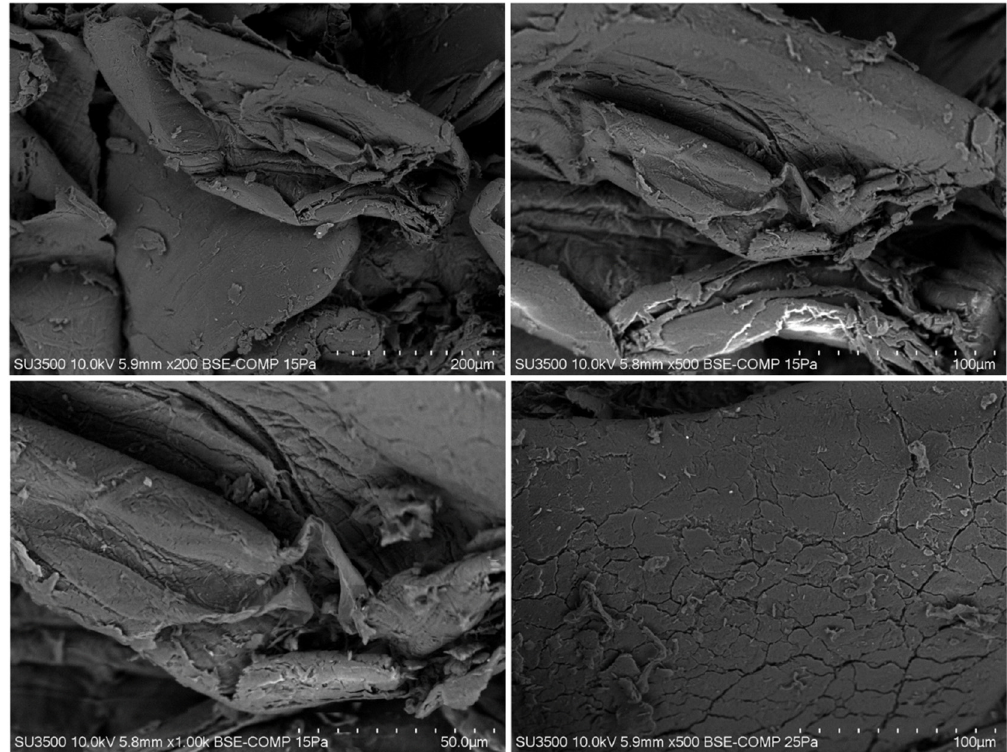
Figure 6. Scanning electron microscopy (SEM) of chitosan extracted from crayfish exoskeleton ( Parastacus Pugnax ).